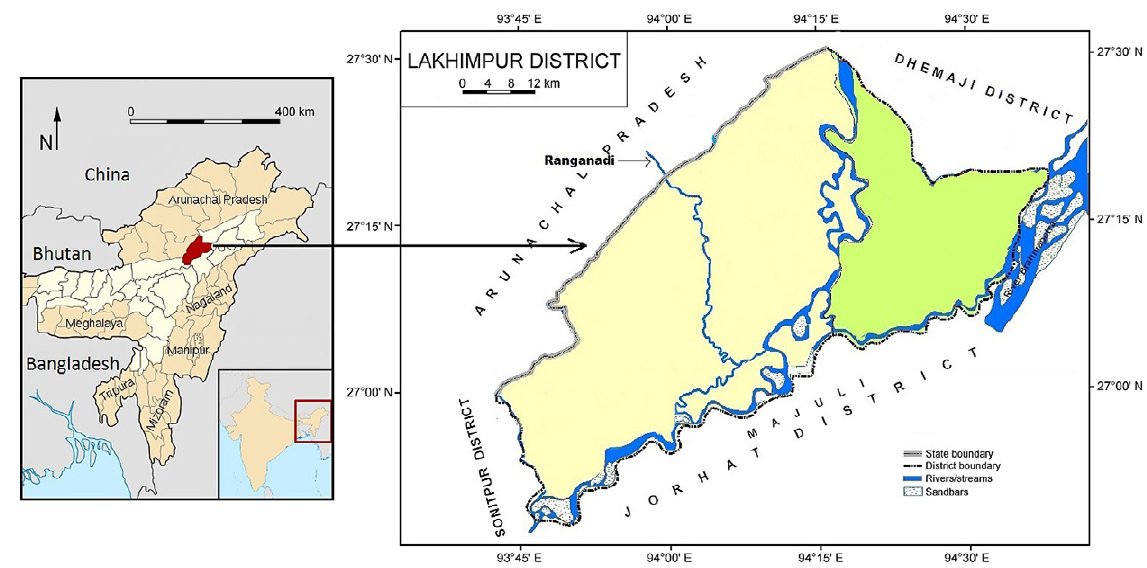
Figure 1. Map of Lakhimpur district showing the Ranganadi